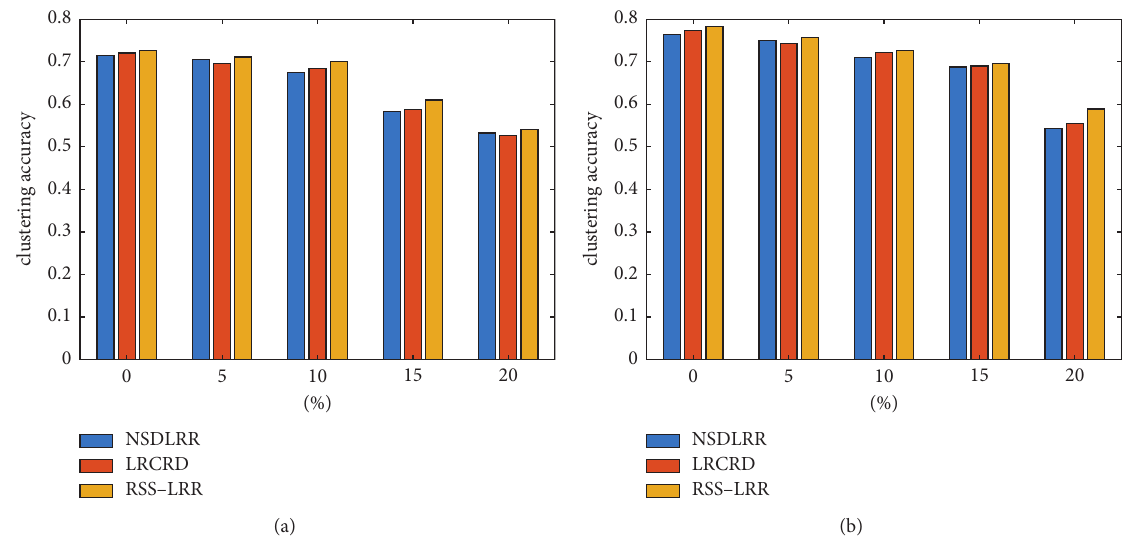
Figure 8: Clustering results concerning the accuracy of different SOTA methods on (a) COIL100 and (b) LFW datasets under various noise levels.